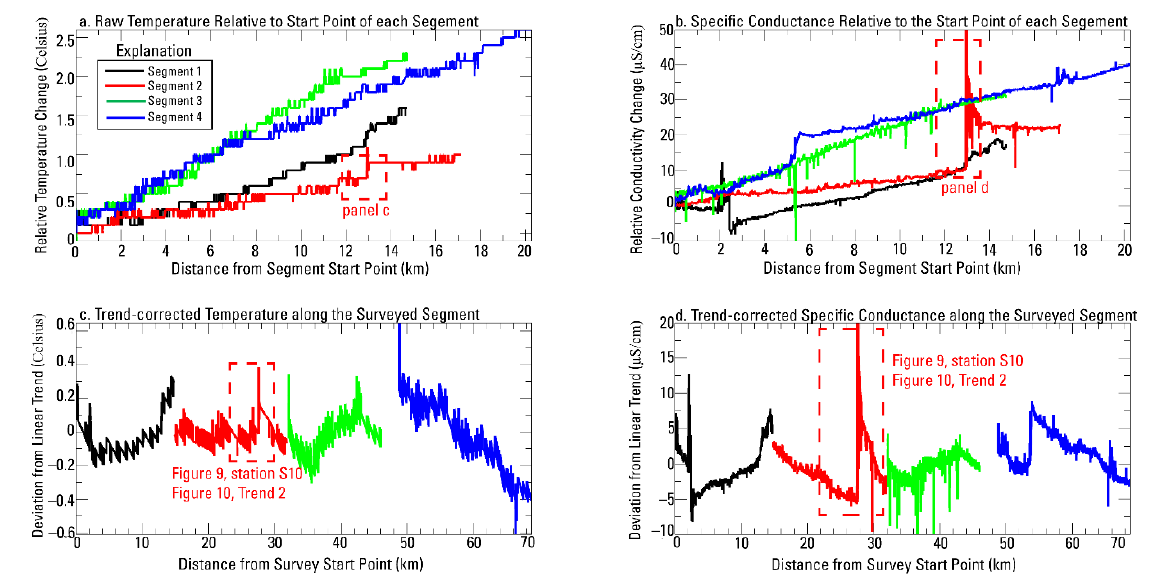
Figure 8. Surface-water temperature and specific conductance data measured in the Rio Grande. ( a ) Raw temperature data measured along individual survey segments, plotted relative to the initial measurements at the upstream ends of the segments. ( b ) Raw specific conductance data measured along individual survey segments, plotted relative to the initial measurements at the upstream ends of the segments. ( c ) Temperature deviations about the linear increases of the data in panel a, versus survey distance. ( d ) Specific conductance deviations about the linear increases of the data in panel b, versus survey distance. The starting and ending points of survey segments 1–4 are depicted in Figures 1–3.